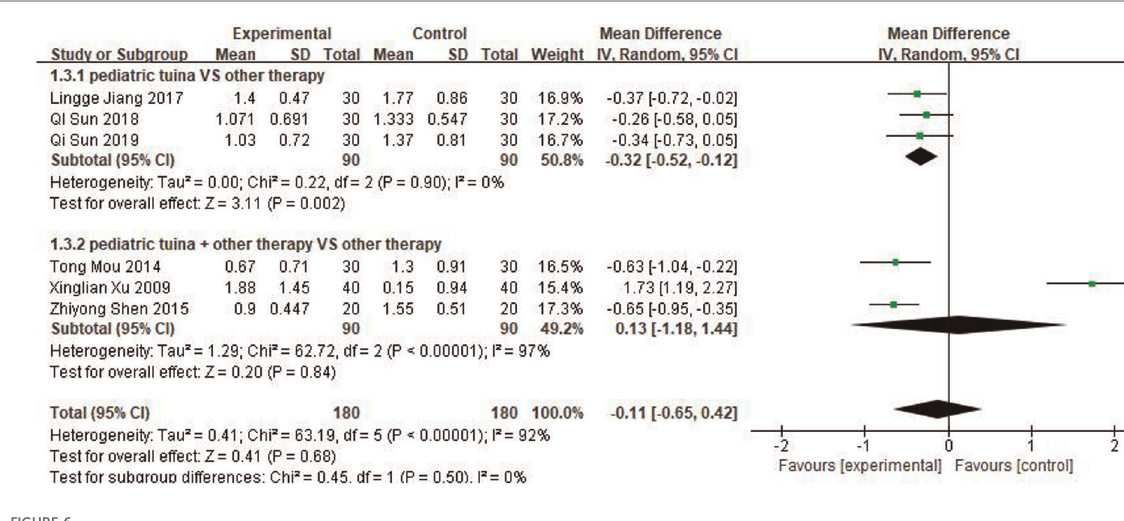
FIGURE 6 Forest plot for the treatment of nasal itching symptom.